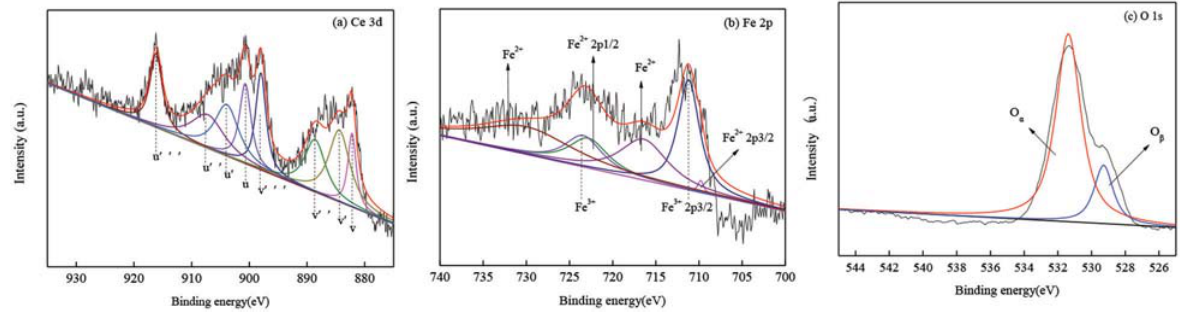
Figure 18: XPS diagram of Sample 4: (a) Ce 3d (b) Fe 2p (c) O